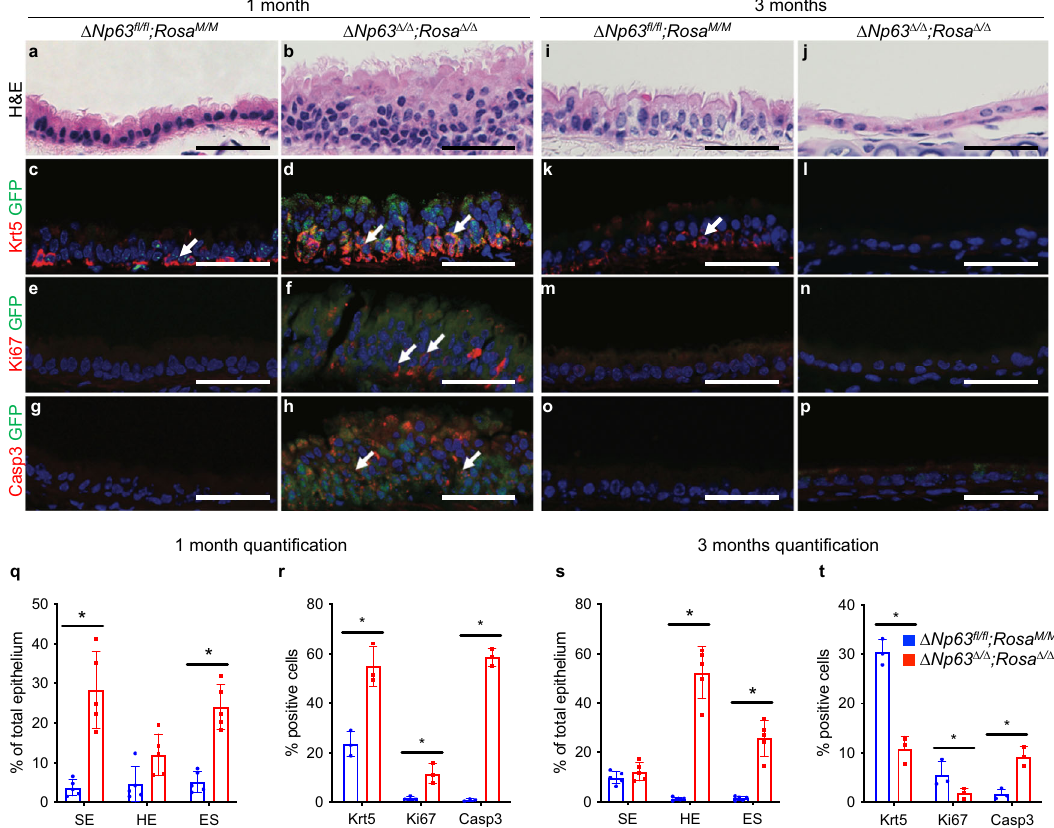
Fig. 2 In vivo Δ Np63 ablation in the tracheal epithelium results in acute increased proliferation leading to long-term depletion of Krt5 + basal cells. a , b Representative H&E stained cross-sections of Δ Np63 fl / fl ; Rosa M/M and Δ Np63 Δ / Δ ; Rosa Δ / Δ tracheal epithelia at 1-month postinfection. c – h Representative staining for Krt5/GFP ( c , d ), Ki67/GFP ( e , f ), and Casp3/GFP ( g , h ), in the same tracheal epithelia shown in a , b . i , j Representative H&E stained cross- sections of Δ Np63 fl / fl ; Rosa M/M and Δ Np63 Δ / Δ ; Rosa Δ / Δ tracheal epithelia at 3 months postinfection. k – p Representative staining for Krt5/GFP ( k , l ), Ki67/ GFP ( m , n ), and Casp3/GFP ( o , p ), in the same tracheal epithelia shown in ( i , j ). All scale bars equal 100 µ m. q Quanti fi cation of the strati fi ed epithelium (SE), the hypoplastic epithelium (HE), and epithelial separation (ES) in Δ Np63 fl / fl ; Rosa M/M and Δ Np63 Δ / Δ ; Rosa Δ / Δ tracheal epithelia at 1-month postinfection. Data were mean ± SD, n = 5, * vs. Δ Np63 fl / fl ; Rosa M/M , P < 0.05, two-tailed Student ’ s t -test. r Quanti fi cation of the staining for Krt5, Ki67, and Casp3 for Δ Np63 fl / fl ; Rosa M/M and Δ Np63 Δ / Δ ; Rosa Δ / Δ tracheal epithelia at 1-month postinfection. Data were mean ± SD, n = 3, * vs. Δ Np63 fl / fl ; Rosa M/M , P < 0.05, two-tailed Student ’ s t- test. s Quanti fi cation of the strati fi ed epithelium (SE), the hypoplastic epithelium (HE), and epithelial separation (ES) in Δ Np63 fl / fl ; Rosa M/M and Δ Np63 Δ / Δ ; Rosa Δ / Δ tracheal epithelia at 3 months postinfection. Data were mean ± SD, n = 5, * vs. Δ Np63 fl / fl ; Rosa M/M , P < 0.05, two-tailed Student ’ s t -test. t Quanti fi cation of the s t aining for Krt5, Ki67, and Casp3 for Δ Np63 fl / fl ;Rosa M/M and Δ Np63 Δ / Δ ; Rosa Δ / Δ tracheal epithelia